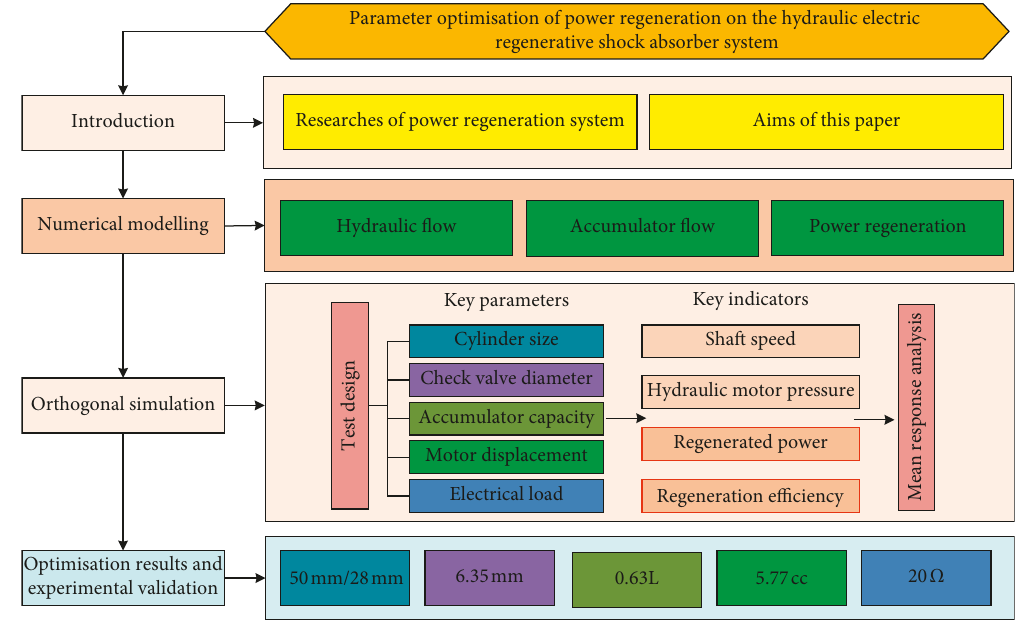
Figure 1: The study procedures of the HERSA.